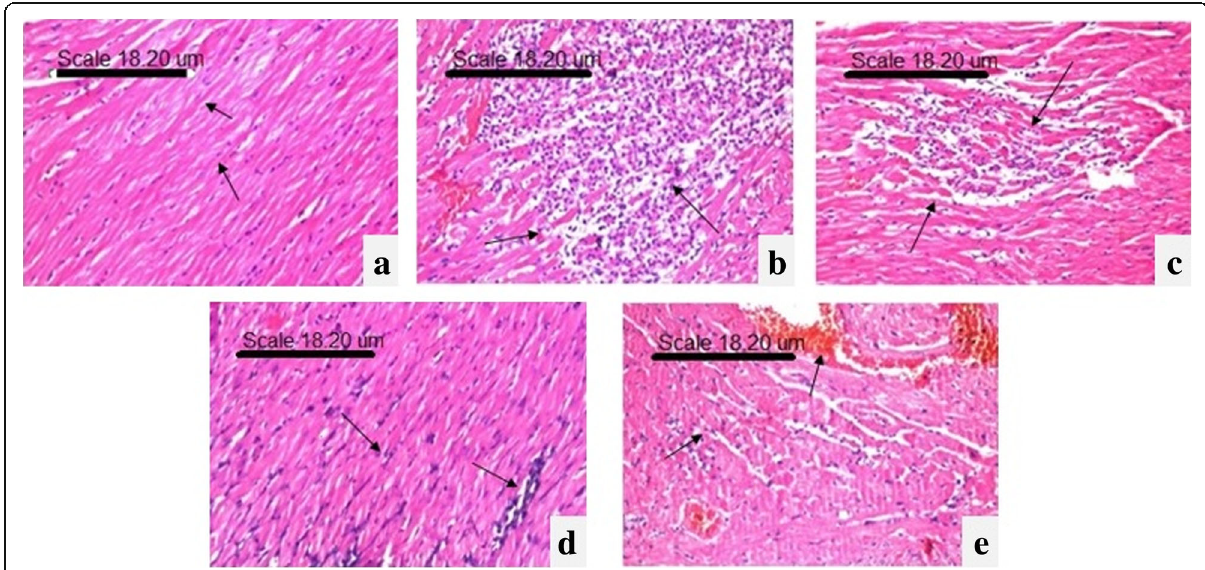
Fig. 1 Representative photomicrographs of heart sections stained by H&E (magnification × 400). a Control group showing normal histological structure of the myocardial bundles (arrows). b ISO-intoxicated group showing multiple focal areas of coagulative necrosis and massive number of inflammatory cells ’ infiltration (arrows). c MP (75 mg/kg)-pretreated group showing focal necrotic areas and marked inflammatory cell infiltration (arrows). d MP (150 mg/kg)-pretreated group showing cardiac muscle bundles with few inflammatory cells ’ infiltration (arrows). e MP